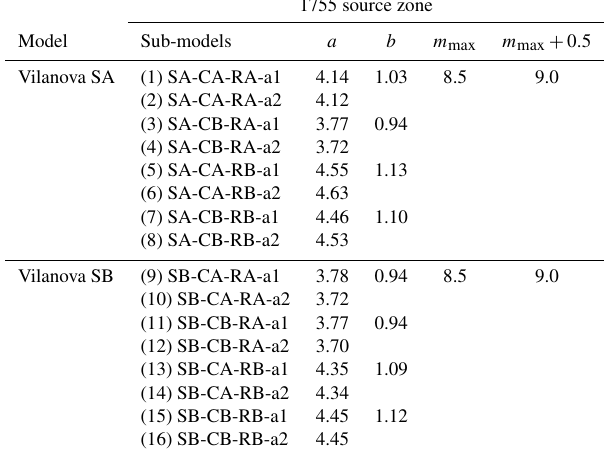
Table 4. Earthquake recurrence parameters ( a , b , m max ) for the 1755 source zone for the 16 combinations (column “Sub-models”) in the logic tree proposed by Vilanova and Fonseca (2007). Each combination has, in addition, two possible maximum magnitudes, resulting in 32 possible recurrence models. Note that a and b are constants and m max represents the maximum magnitude.